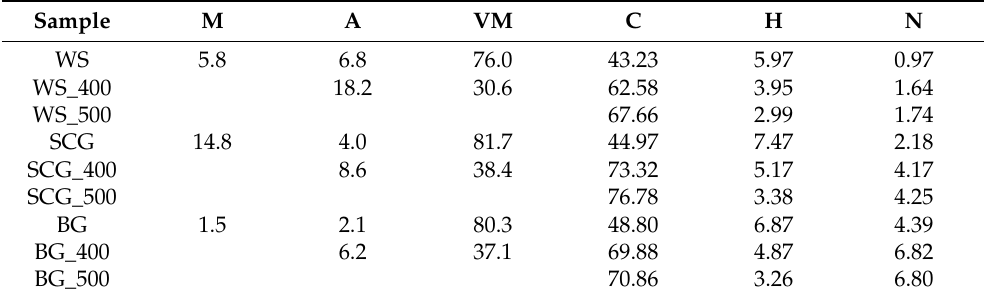
Table 1. Proximate and ultimate analysis of studied feedstock and biochars, wt. % (M—moisture,